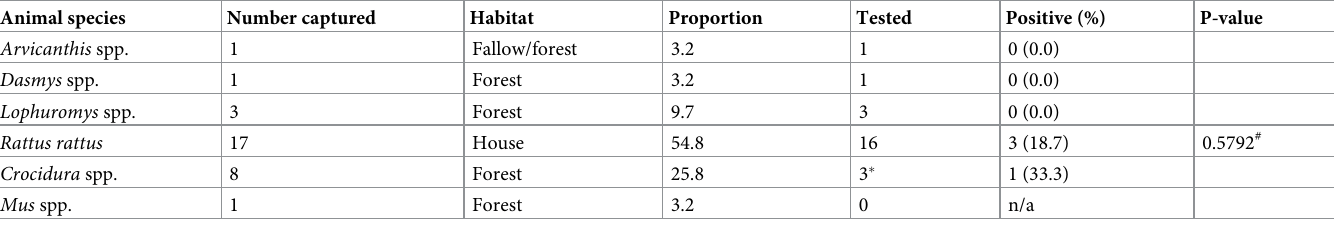
Table 2. Rodents and insectivores collected in Kagera study sites.